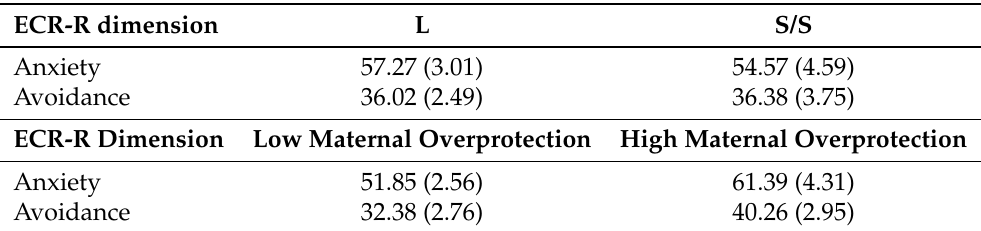
Table 3. Mean values of variables with main effects. Top section: mean values in 5-HTTLPR S/S homozygotes and L-carriers on the ECR-R variables. Below section: mean values in low and high maternal overprotection on the ECR-R variables. Standard error means are reported between parentheses.